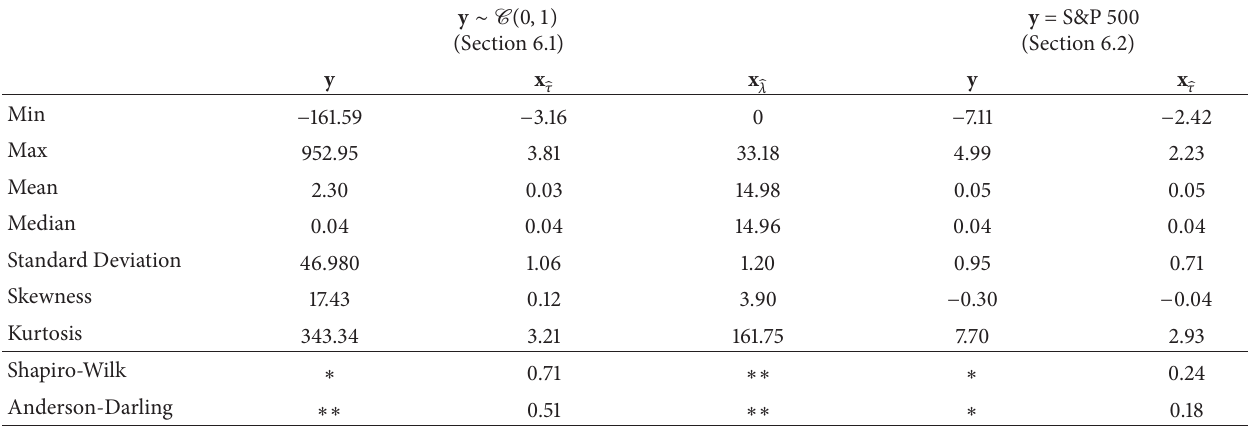
Table 3: Summary statistics for observed (heavy-tailed) y and back-transformed (Gaussianized) data x ̂𝜏 <2.2 ⋅ 10 −16